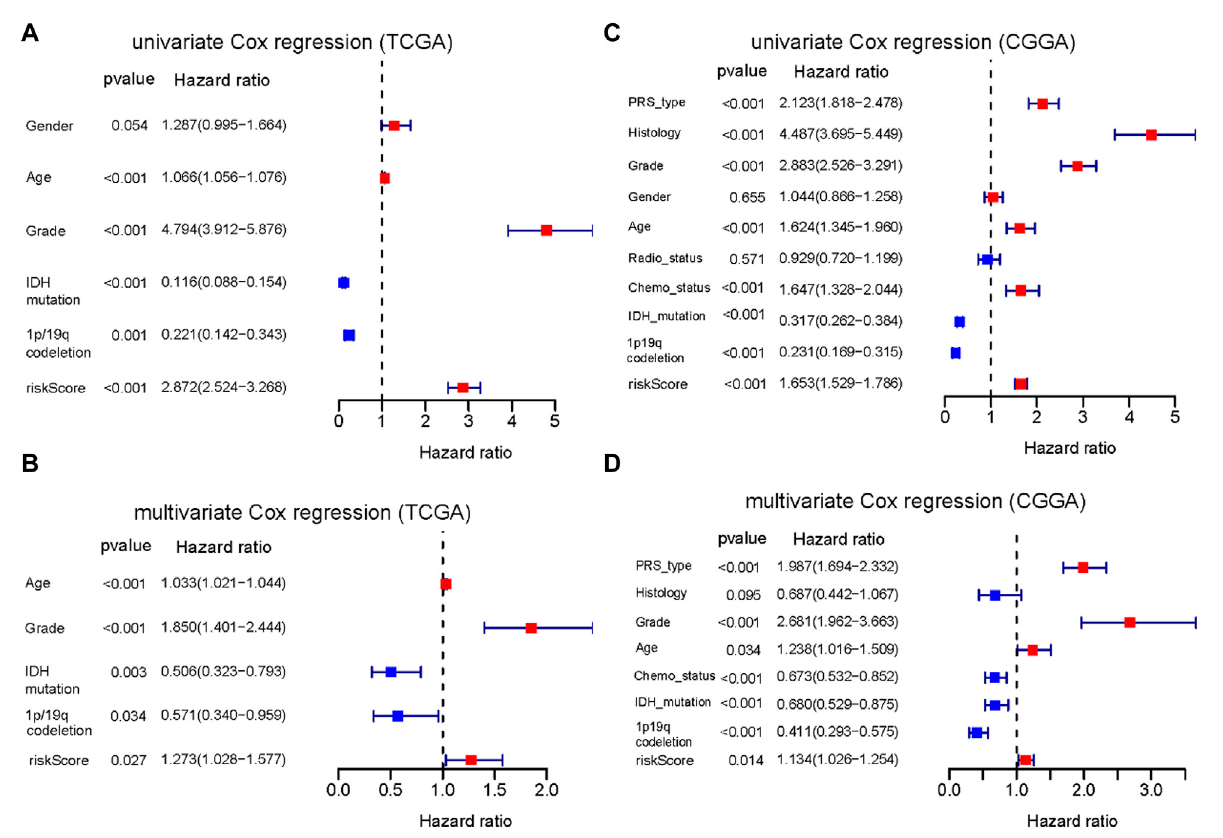
FIGURE 6 Results of the univariate and multivariate Cox regression analyses regarding OS. (A) Result of the univariate Cox regression analyses in the TCGA training cohort. (B) Result of the multivariate Cox regression analyses in the TCGA training cohort. (C) Result of the univariate Cox regression analyses in the CGGA training cohort. (D) Result of the multivariate Cox regression analyses in the CGGA training